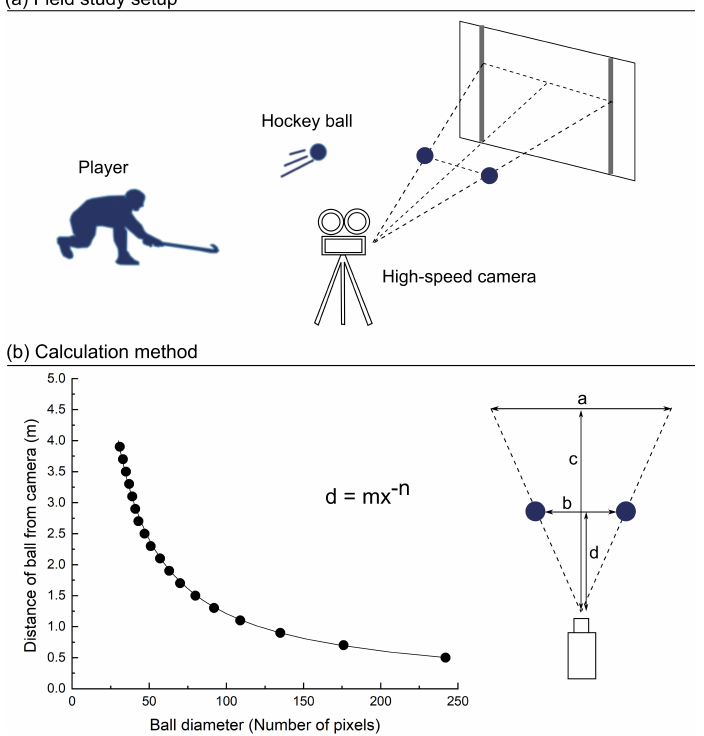
Figure 1. Graphical illustration representing ( a ) field study test setup including player, hockey ball, high-speed camera and board including vertical lines used to measure the ball speed and ( b ) calculation method of the ball speed considering the parallax